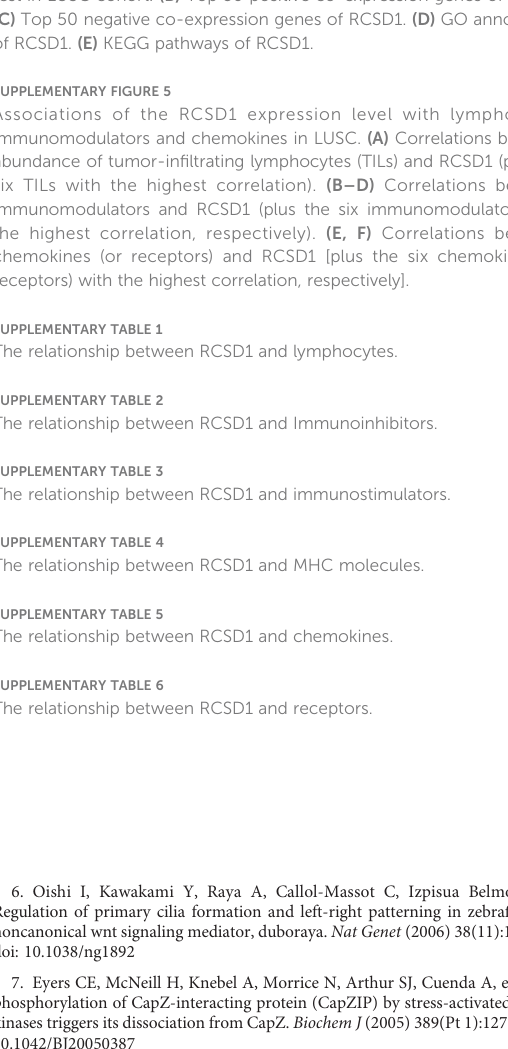
SUPPLEMENTARY FIGURE 1 RCSD1 phosphoprotein expression in tumors. (A – G) in LUAD. (H – L) in BRCA. (M – T) in KIRC. SUPPLEMENTARY FIGURE 2 The relationship between RCSD1 expression and pan-cancer molecular subtypes. (A) in ACC, (B) in BRCA, (C) in COAD, (D) in ESCA, (E) in HNSC, (F) in KIRP, (G) in LGG, (H) in LIHC, (I) in LUSC, (J) in OV, (K) in PCPG, (L) in PRAD, (M) in STAD, (N) in UCEC. SUPPLEMENTARY FIGURE 3 RCSD1 differential expression in LUSC with different clinical subgroups.